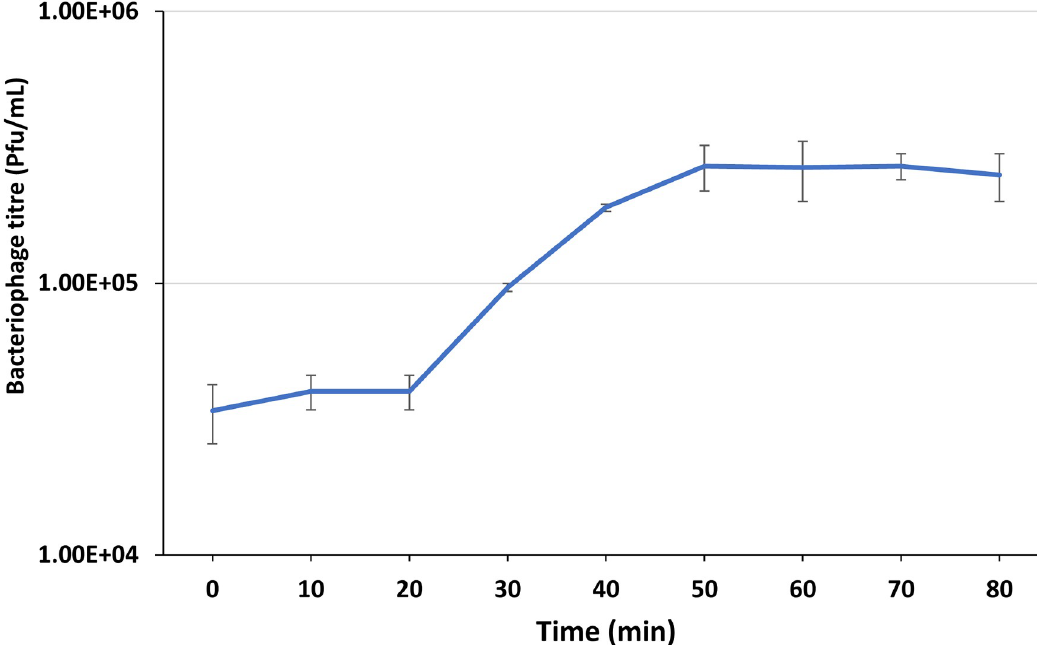
Fig 2. KMI8 one step growth curve. Error bars represent standard error of mean, calculated from three independent experiments.